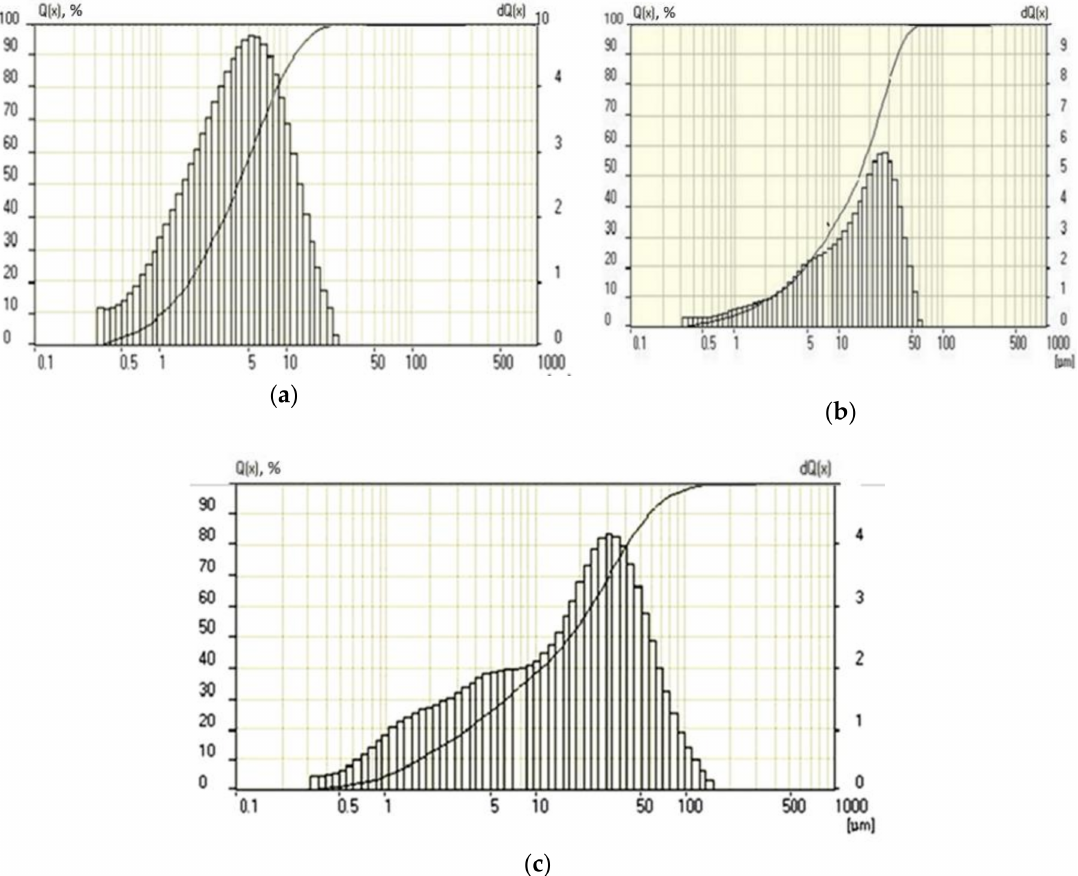
Figure 1. Particle size distribution function Q(x) and a probability density dQ(x) : ( a ) finely dis- persed cement (1000 m 2 /kg); ( b ) conventional Portland cement; ( c ) finely ground granulated blast furnace